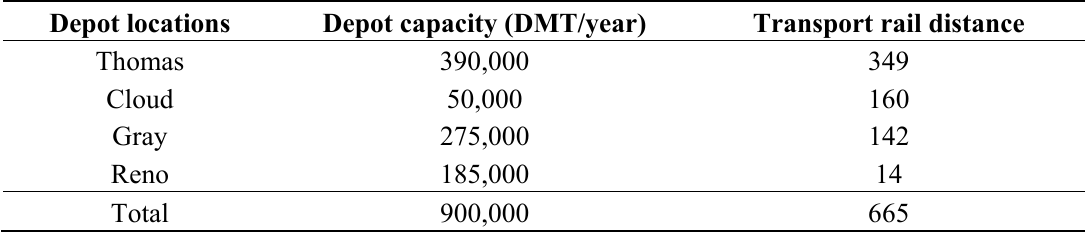
Table 1. Preprocessing depot capacities and true rail distance from depots to the single biorefinery in Scenario 1. DMT: dry matter ton.